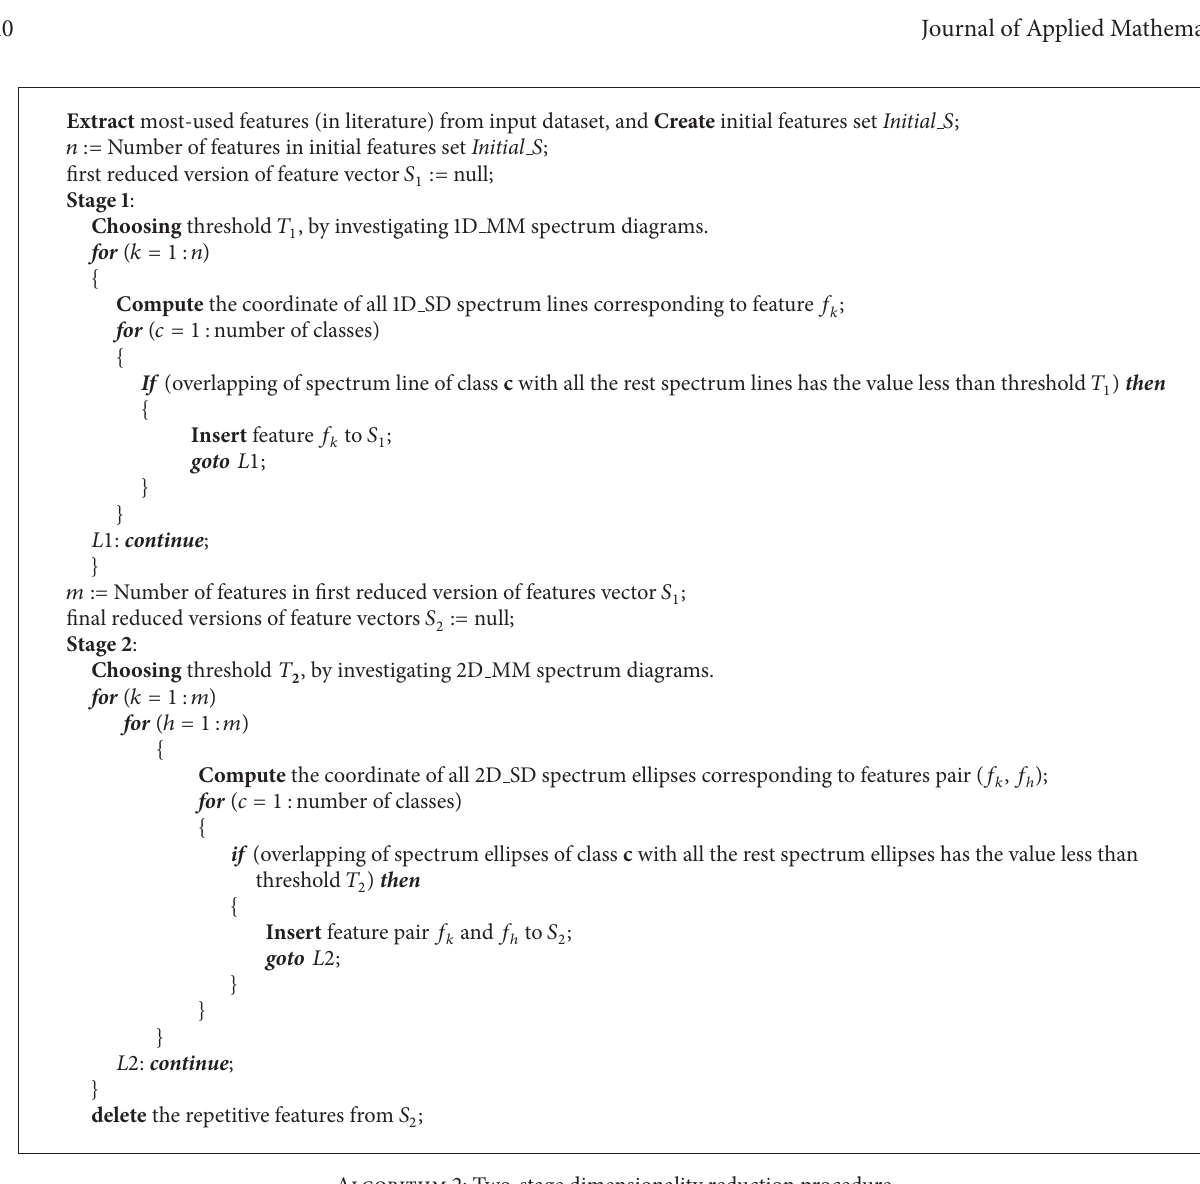
Algorithm 2: Two-stage dimensionality reduction